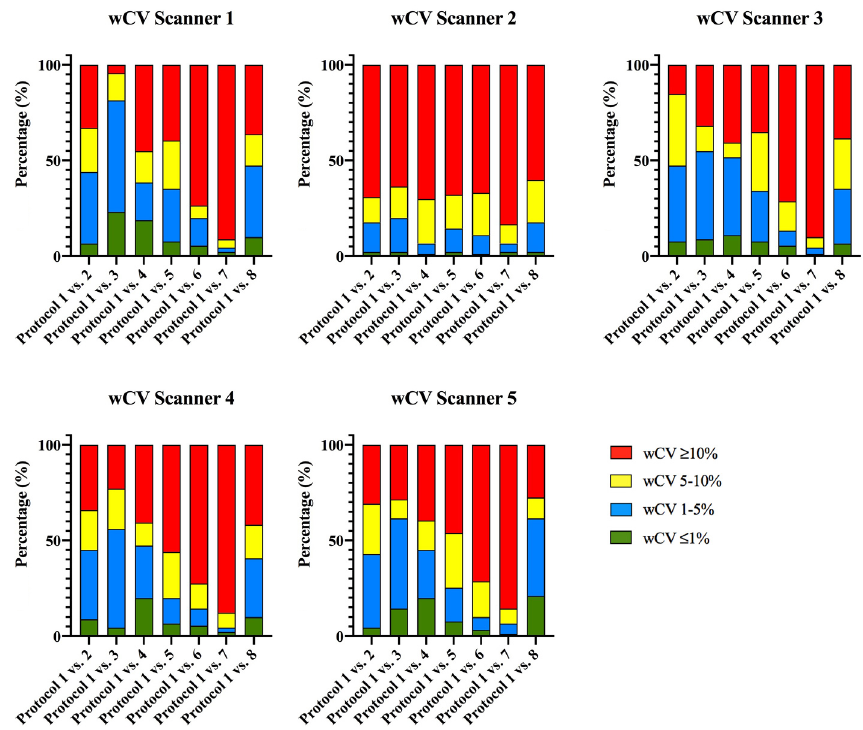
Figure 4. Histograms representing the percentage of features according to their wCV value for the five CT scanners when changing some parameters from protocol 1.